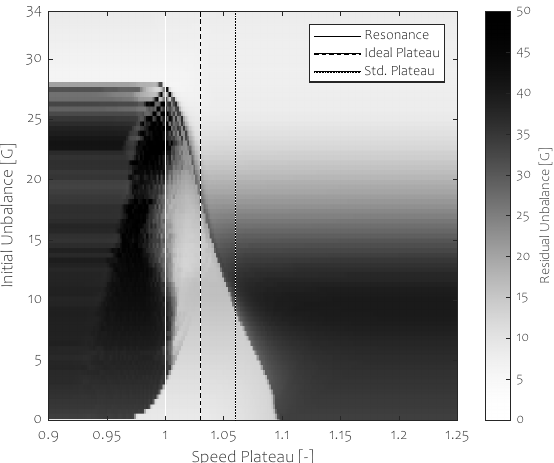
Figure 15. Effect of the initial unbalance on the valid lower speed plateau range, µ r = 1, c r = 0.5. The ideal speed plateau is